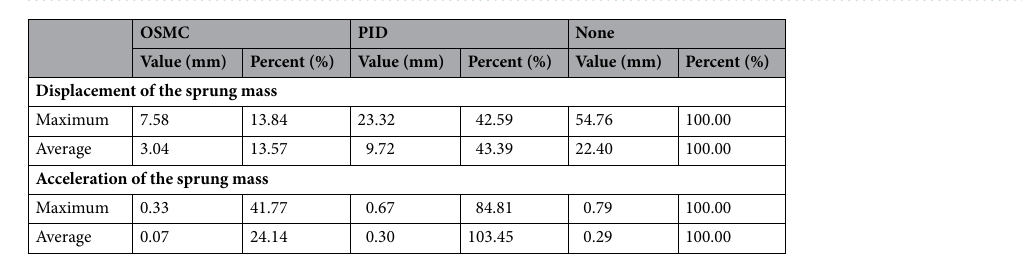
Table 2. Results of the case